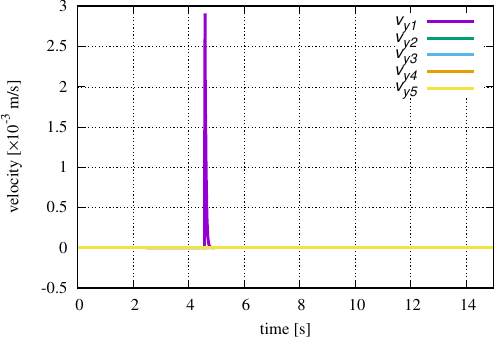
Figure 25. Case 2: Time variation of the velocities in the axial direction.